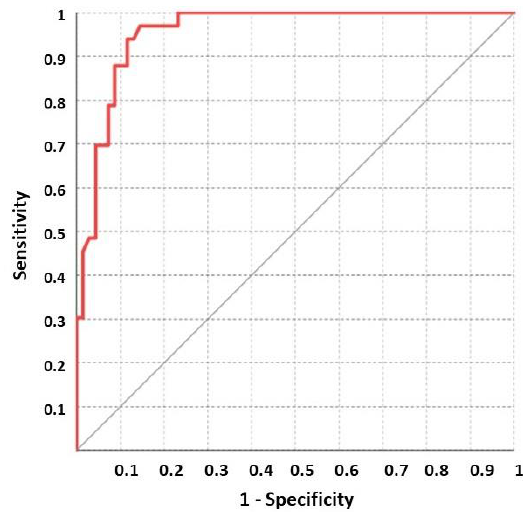
Figure 1. ROC analysis on CHIT1 between active sarcoidosis and FUO patients.